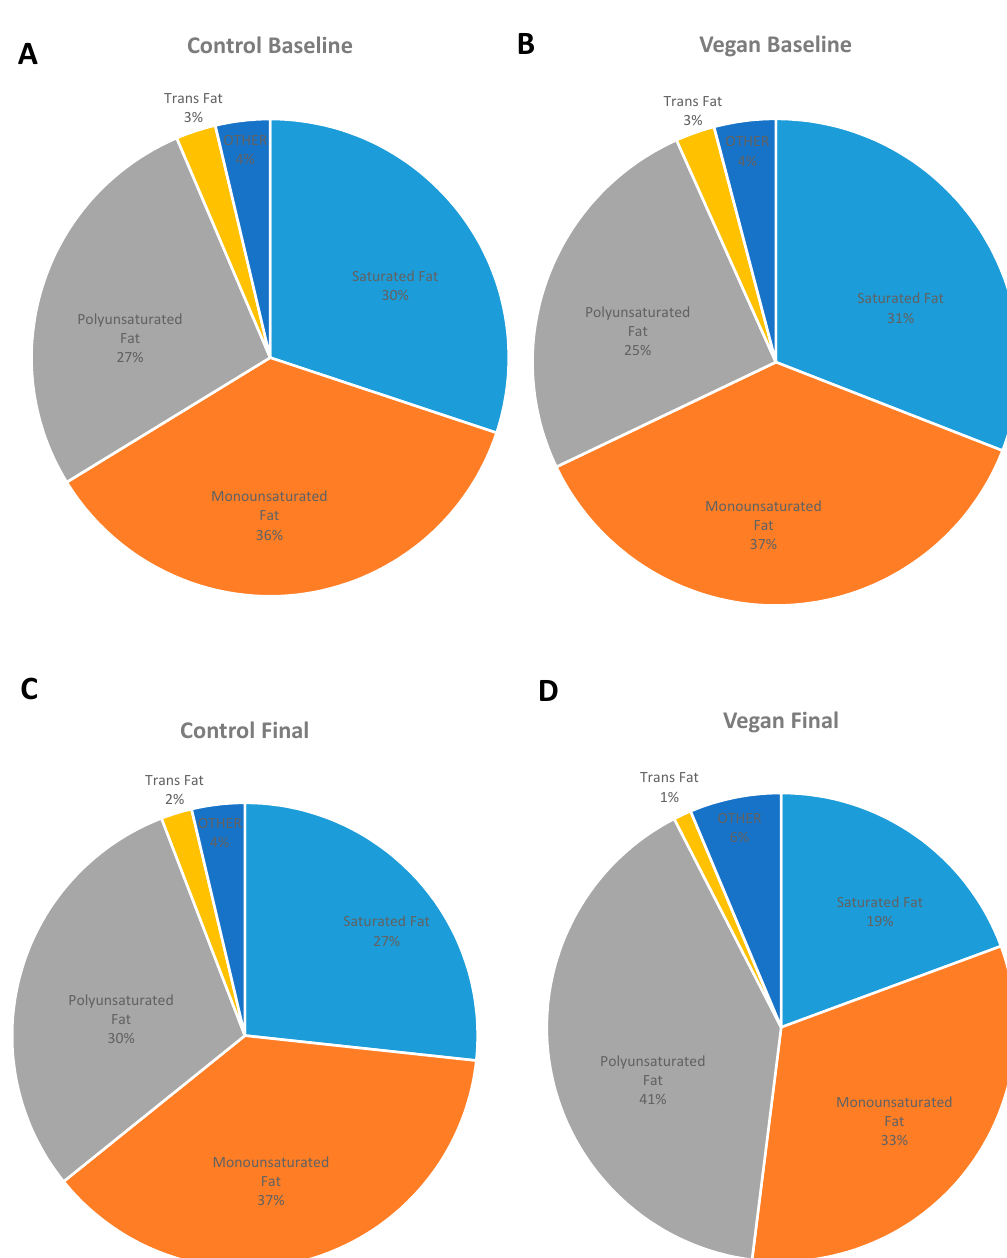
Figure 2. Changes in fatty acid profiles between vegans and controls at baseline and 16 weeks. ( A ) Control Baseline, ( B ) Vegan Baseline ( C ) Control Final, ( D ) Vegan Final. MUFA, monounsaturated fatty acid; PUFA, polyunsaturated fatty